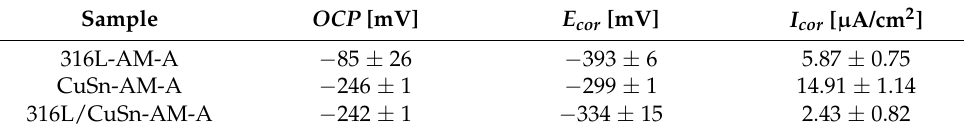
Table 5. LSV characteristic values of single and